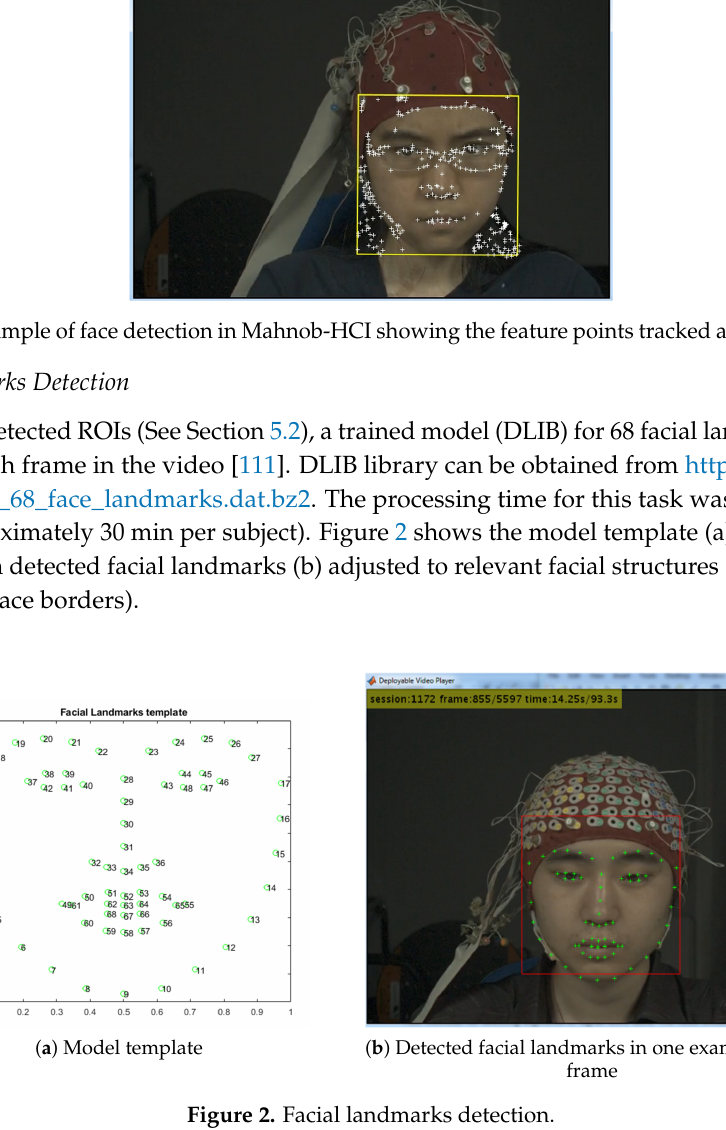
Figure 2. Facial landmarks